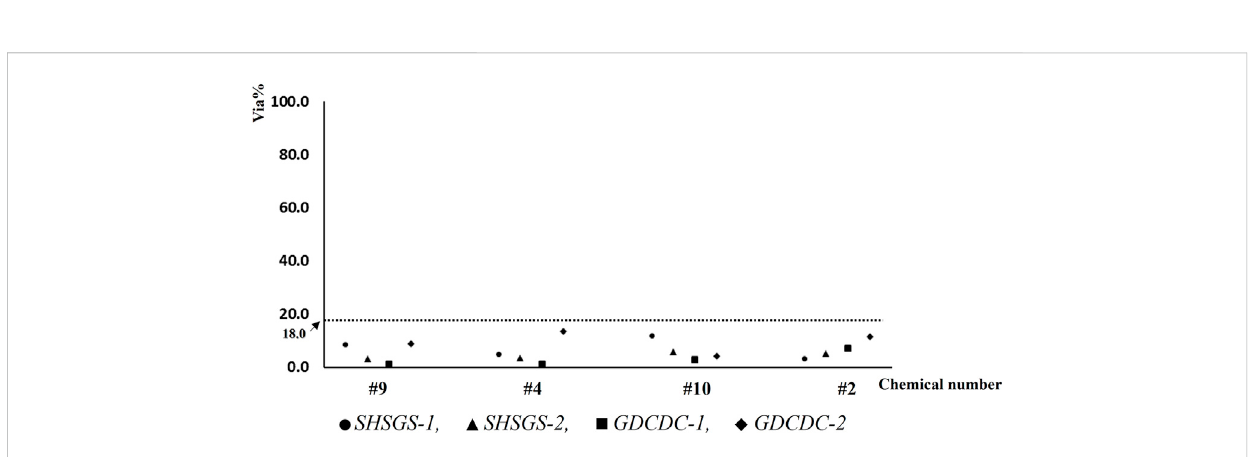
FIGURE 3 SD of cell viability for each run of test chemicals.